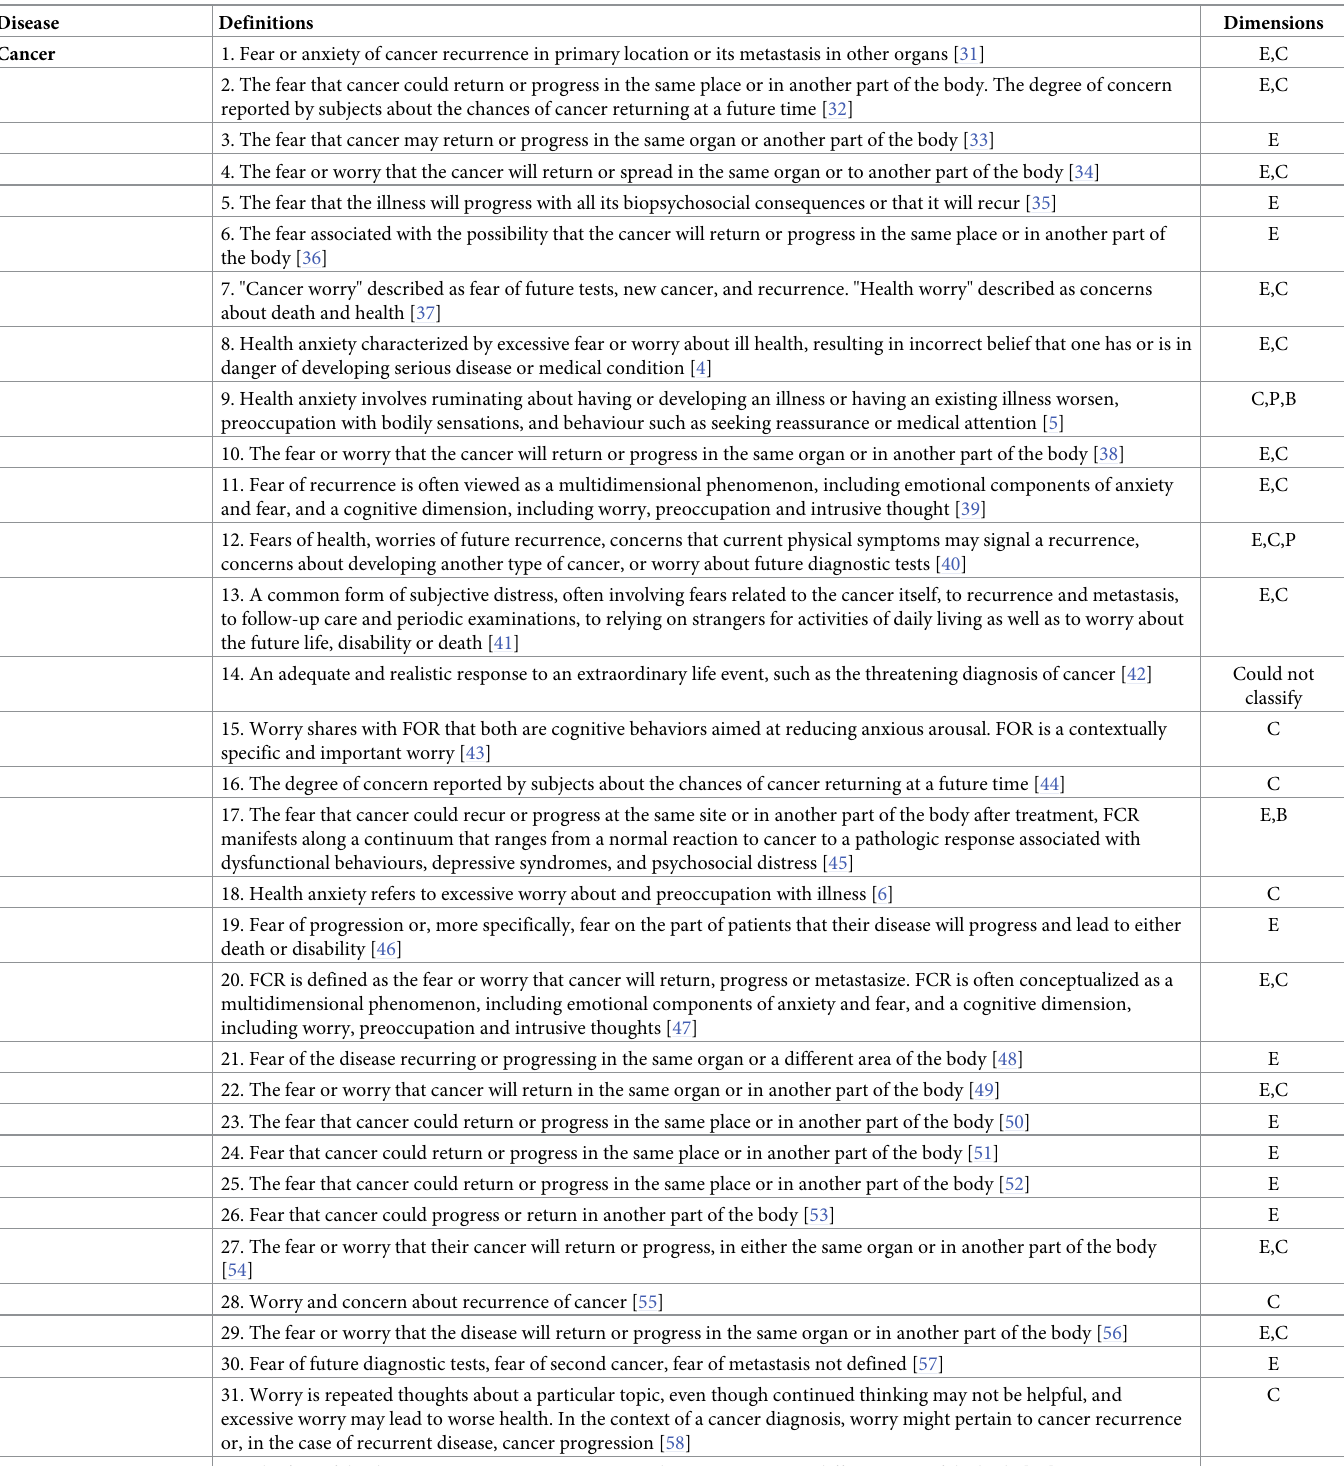
Table 3. List of definitions and their dimensions by chronic illness.